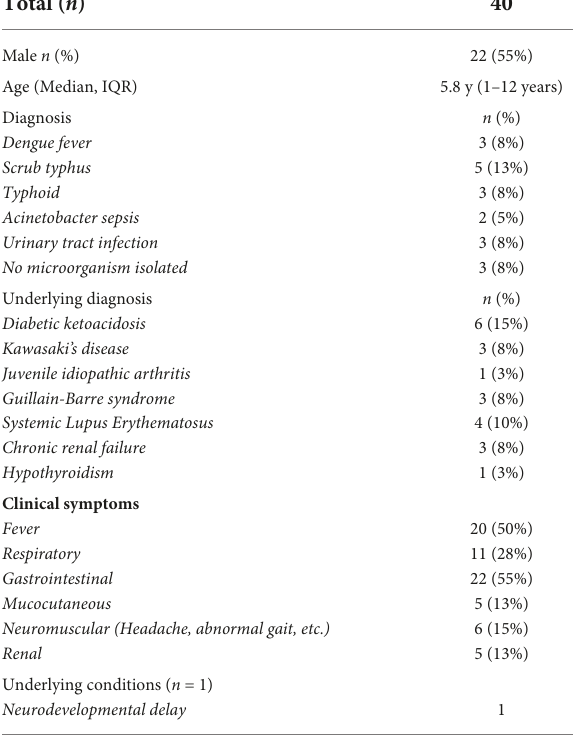
TABLE 2 Additional features of children with other